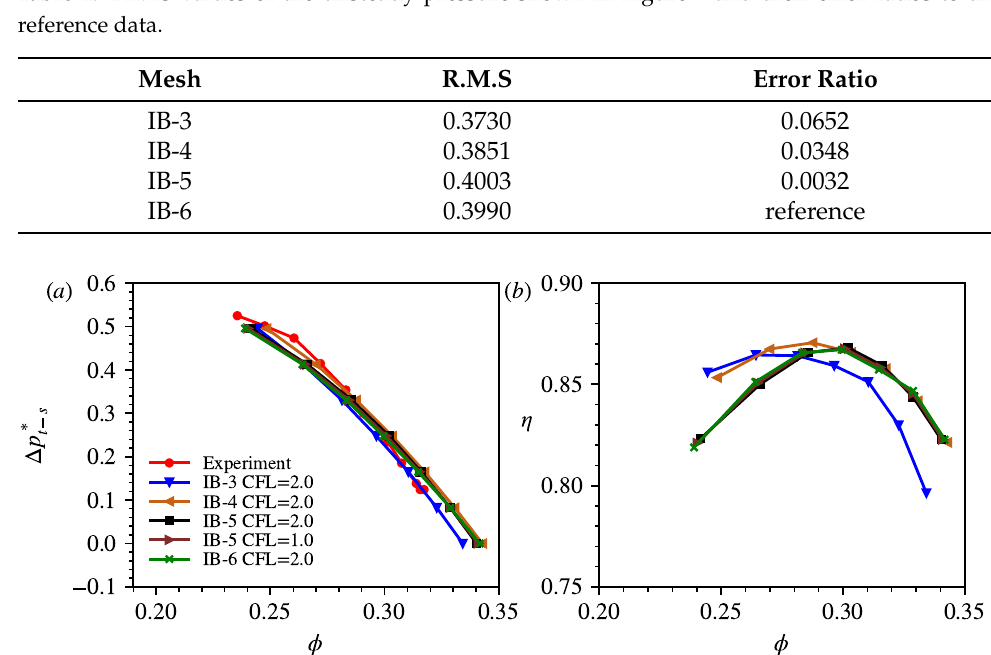
Figure 5. Comparison of the performance obtained by the experiment and the present IB method with different numbers of refinement level: ( a ) Static-to-total pressure rise coefficient; ( b ) adiabatic